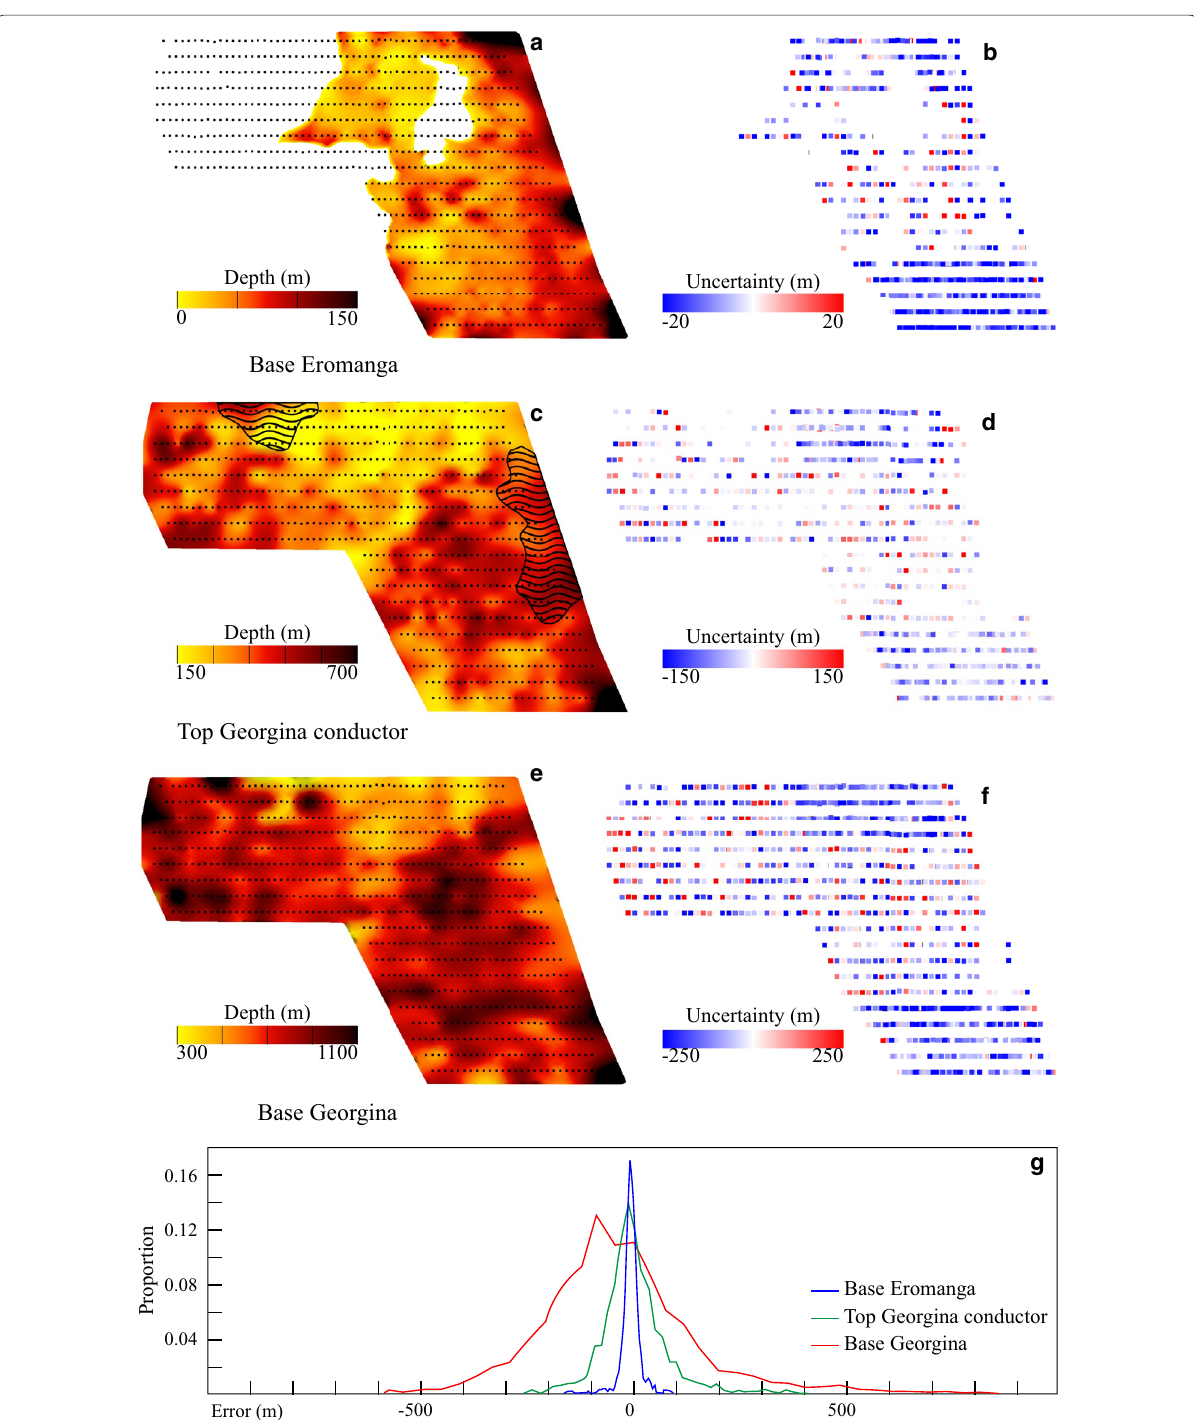
Fig. 11 Interpreted geological layers and associated uncertainty. a Interpreted base of Eromanga Basin, extents limited to location of Eromanga Basin sediments (Fig. 1b). b Uncertainty of base of Eromanga at each MT site, where a negative value indicates the final interpretation surface is shallower than the 1D inversion result, and a positive value indicates the interpretation is deeper than the 1D inversion result at that site. c Interpreted top of Georgina conductor (C2), black hatched areas indicate areas where the unit may be missing. d Uncertainty of the top of Georgina conductor layer based on difference between interpretation surface and 1D inversion pick. e Interpreted base Georgina (basement). f Uncertainty of the base Georgina interface based on difference between interpretation surface and 1D inversion pick. g Histogram distribution of errors for